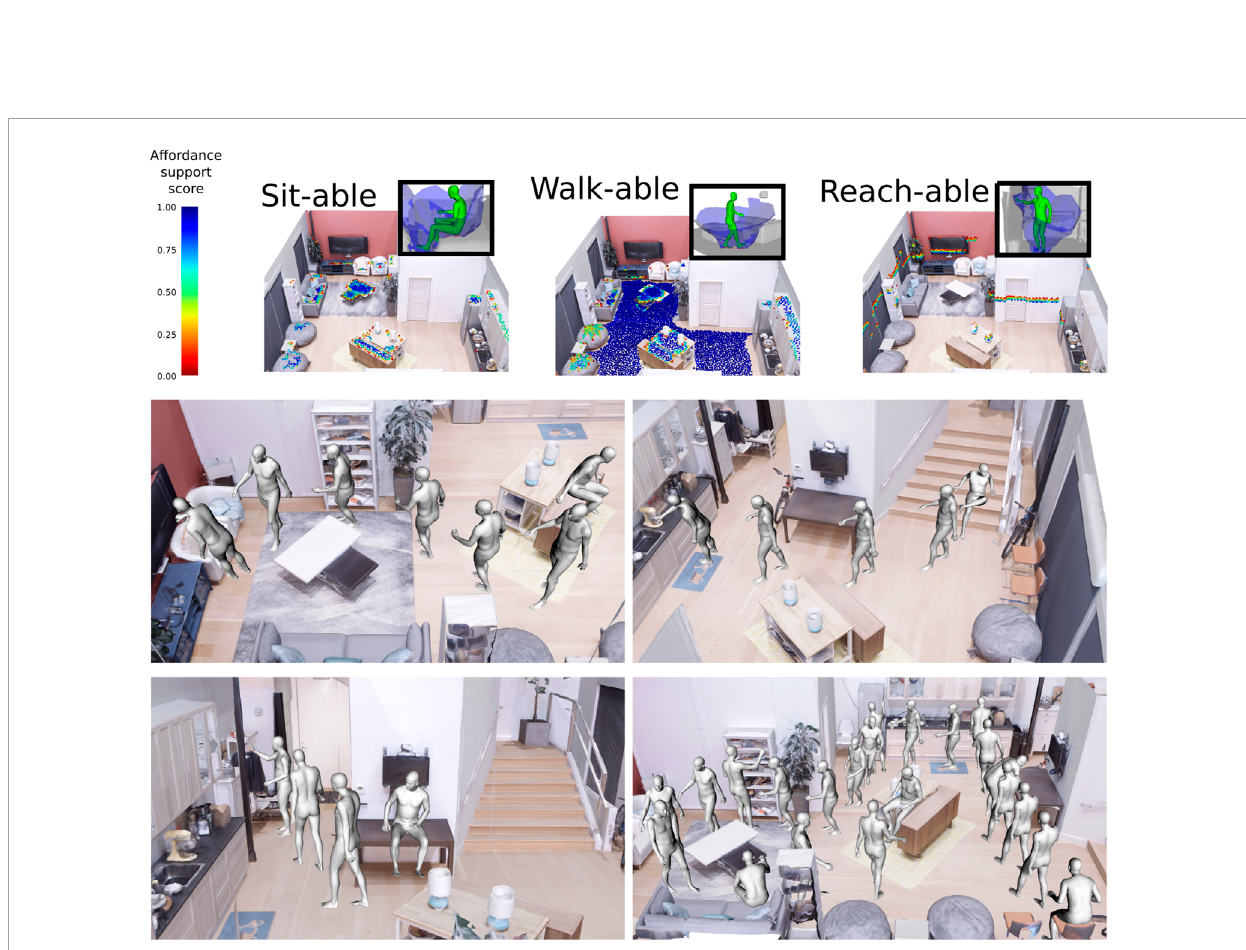
FIGURE 8 AROS can be used to create maps for action planning. Top: Many locations in an environment are evaluated for three different affordances (sit-able, walk-able, and reach-able). Bottom: AROS scores used to plan concatenated action milestones.